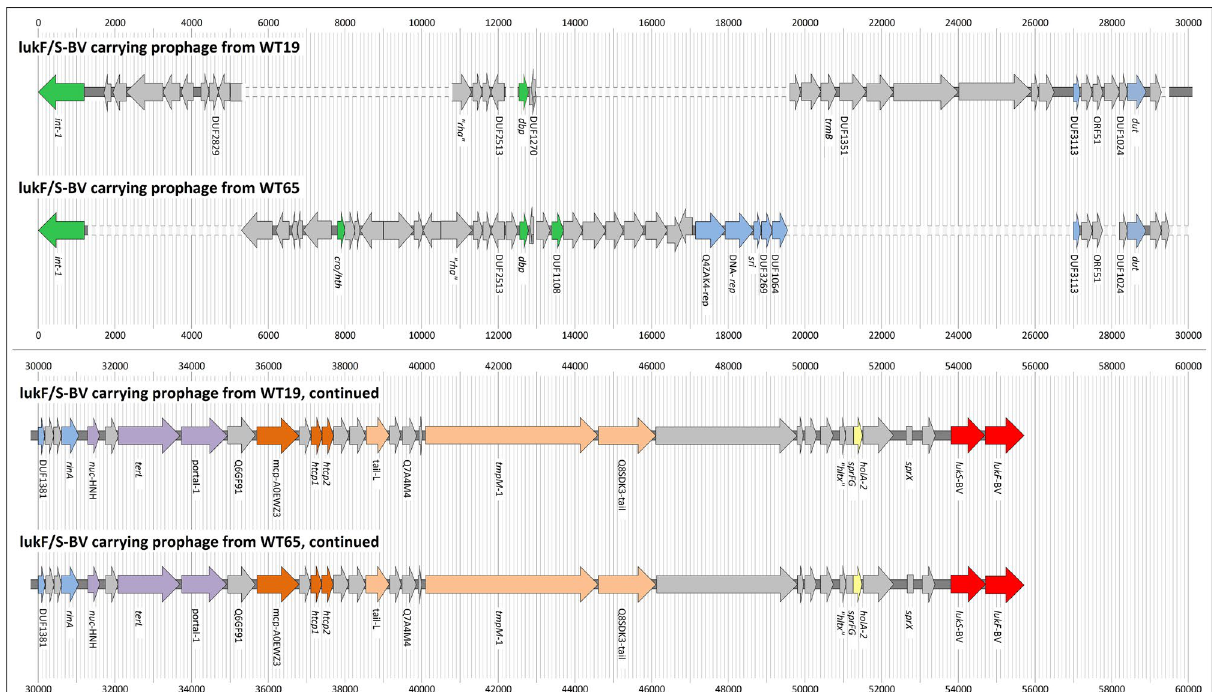
Figure 4. Schematic representation of the aligned sequences of the lukF/S -BV prophages from WT19 and WT65.